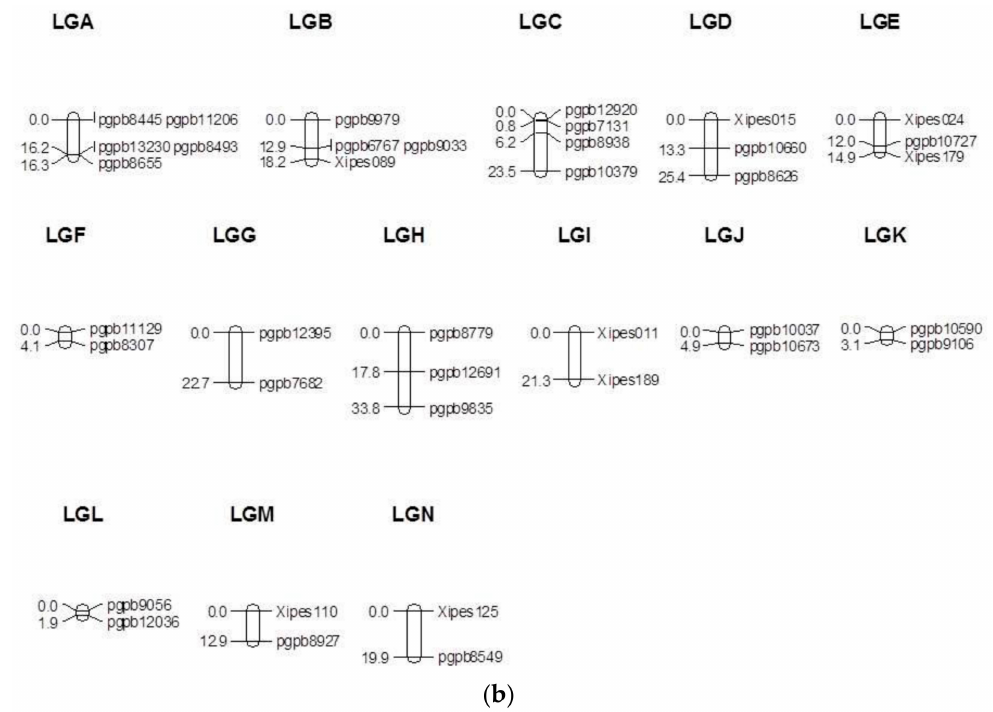
Figure 1. ( a ) Base linkage map (linkage groups LG1–LG7) of the pearl millet recombinant inbred line (RIL) population based on the cross (ICMS 8511-deriv × AIMP 92901-deriv-08); ( b ) Linked fragments from the genetic map of the pearl millet RIL population based on the cross (ICMS 8511-deriv × AIMP 92901-deriv-08).